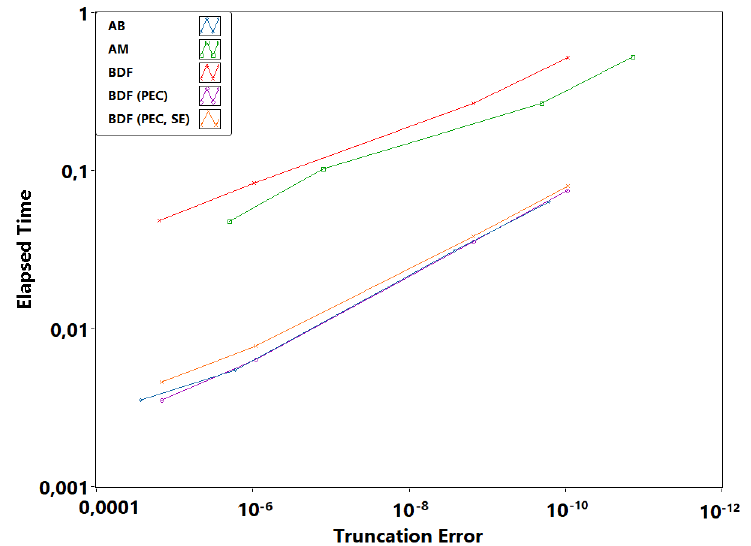
Figure 7. Comparison of the error versus elapsed time for the family of investigated methods on the test Rössler